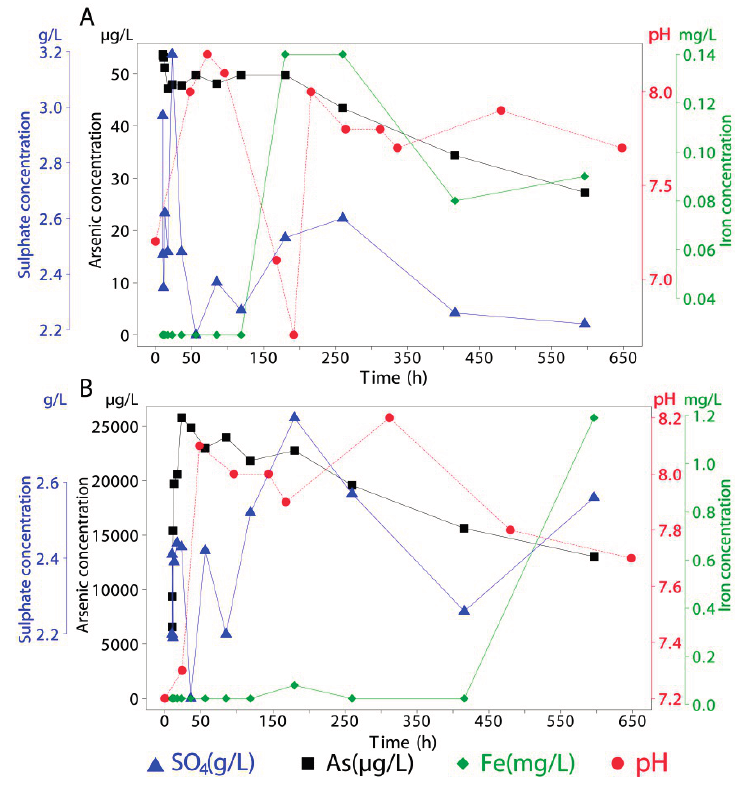
Figure 6. Arsenic release test for goethite. ( A ) Arsenic release from co-precipitated goethite and ( B ) arsenic release from adsorbed